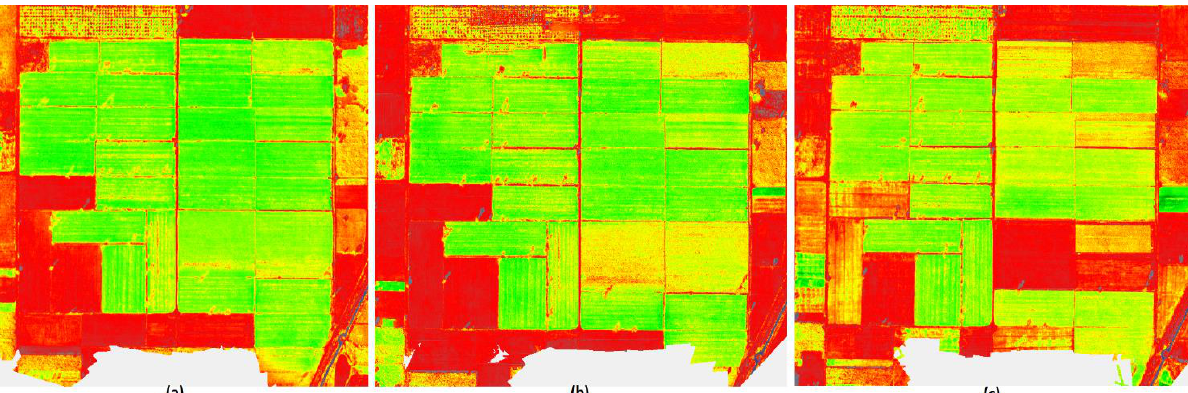
Figure 7. Resultant NDVI Orthomosaic of (a) 12 th November (b) First flight of 26 th November (c) First flight of 17 th December 2016